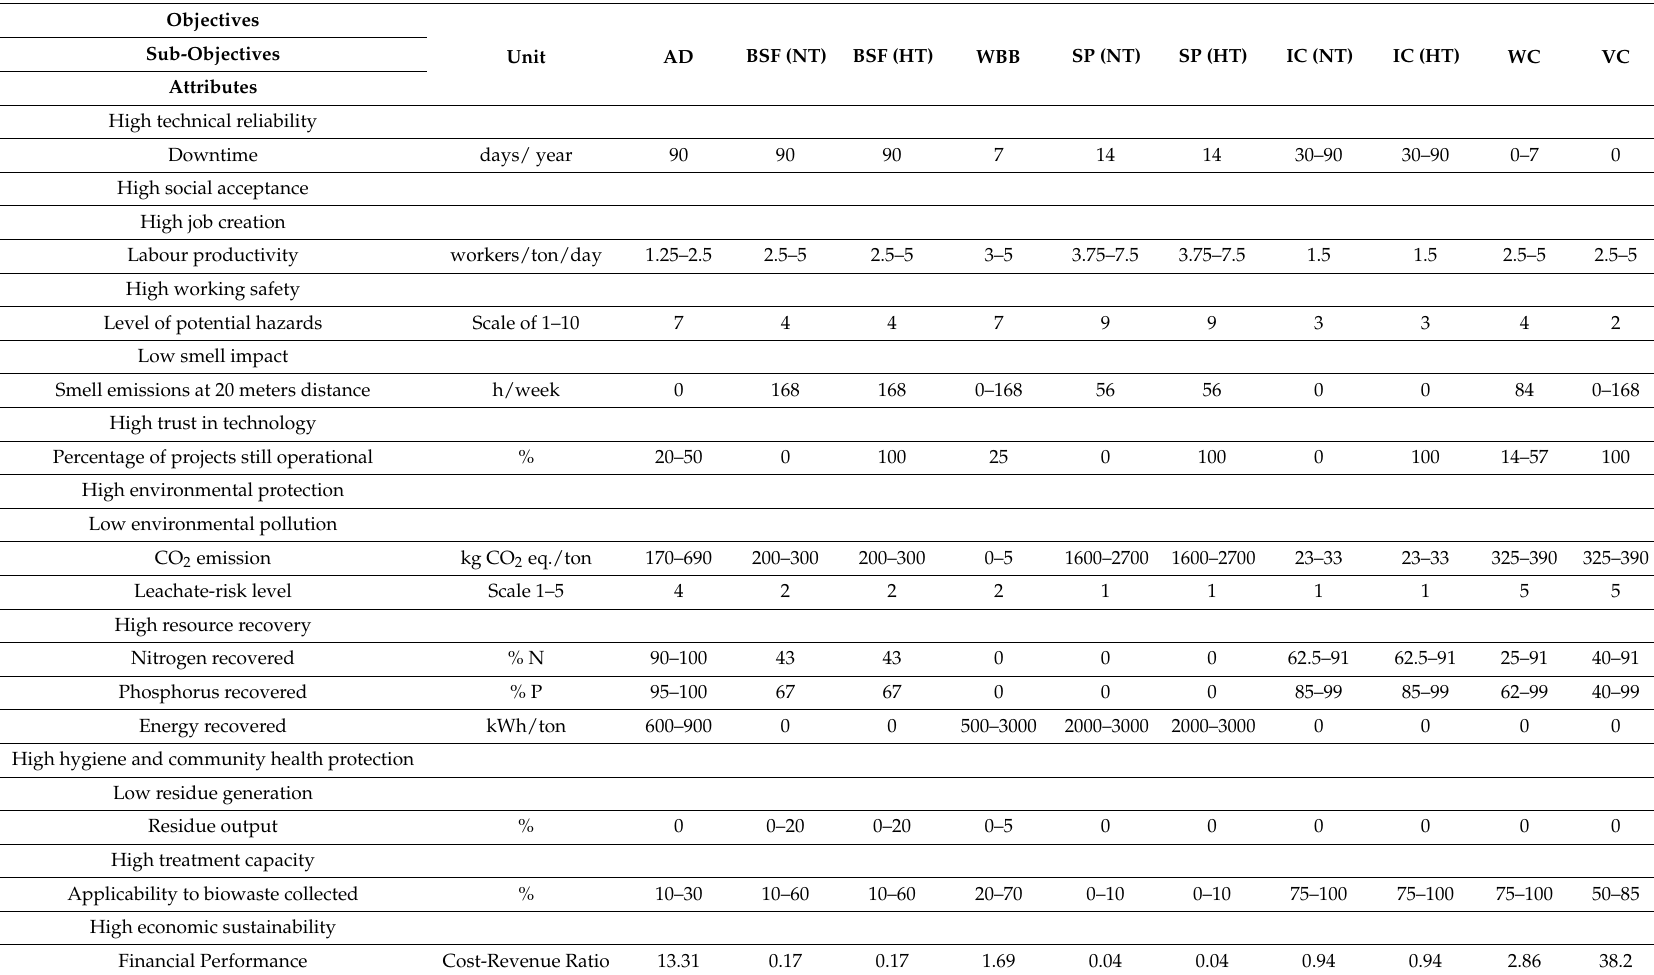
Table 2. Estimated performance for the considered technology